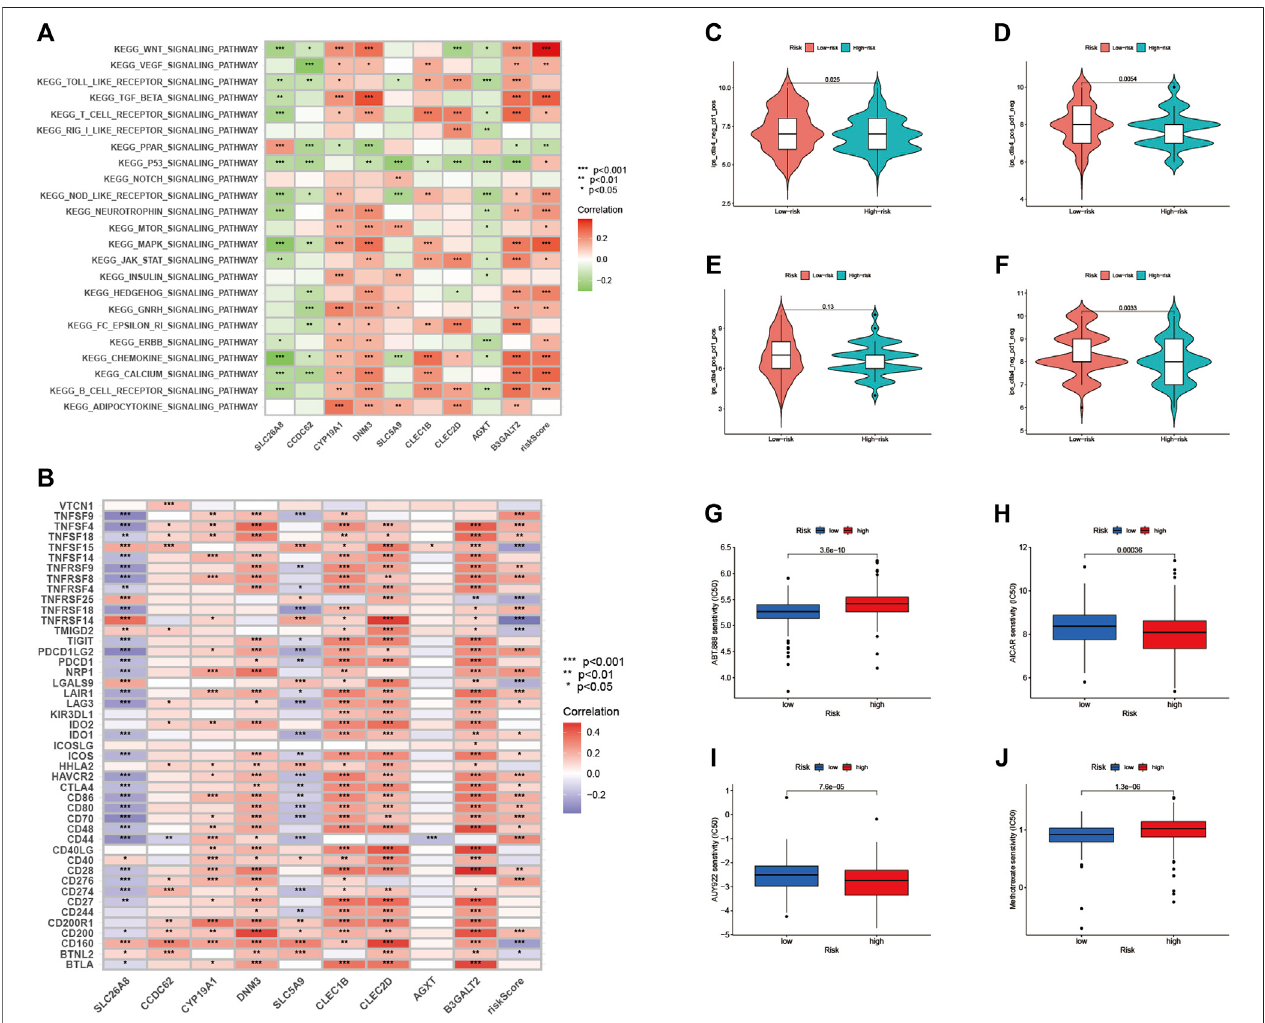
FIGURE 10 | Enrichment pathways for GSVA (A) heatmap showing the correlation of representative pathway items on KEGG with risk scores. Predicting immunotherapy response (B) Association of immune checkpoint blockade gene expression levels with risk scores (C – F) IPS score distribution map. Estimates of chemotherapy effect risk scores. Sensitivity analysis of (G) Veliparib in patients with high and low risk scores. Sensitivity analysis of (H) cisplatin in patients with high and low risk scores (I) Sensitivity analysis of paclitaxel in patients with high and low risk scores (J) Sensitivity analysis of methotrexate in patients with high and low risk